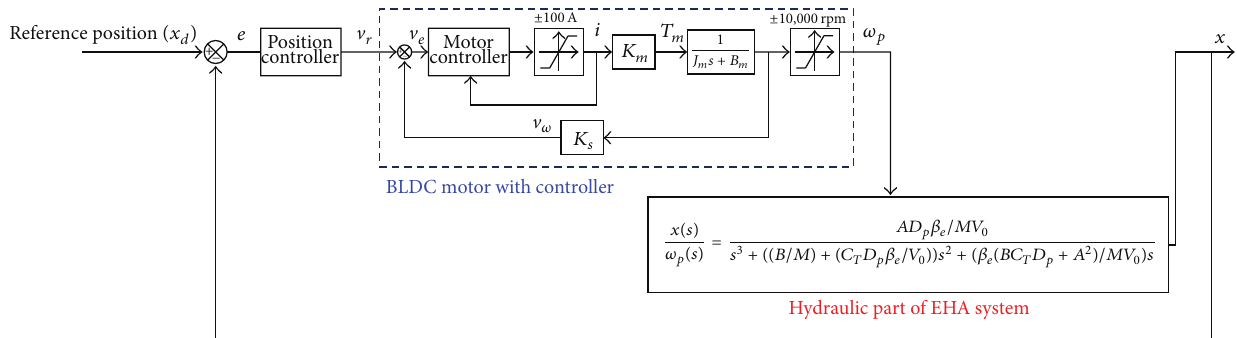
Figure 8: Block diagram for the position control system of the